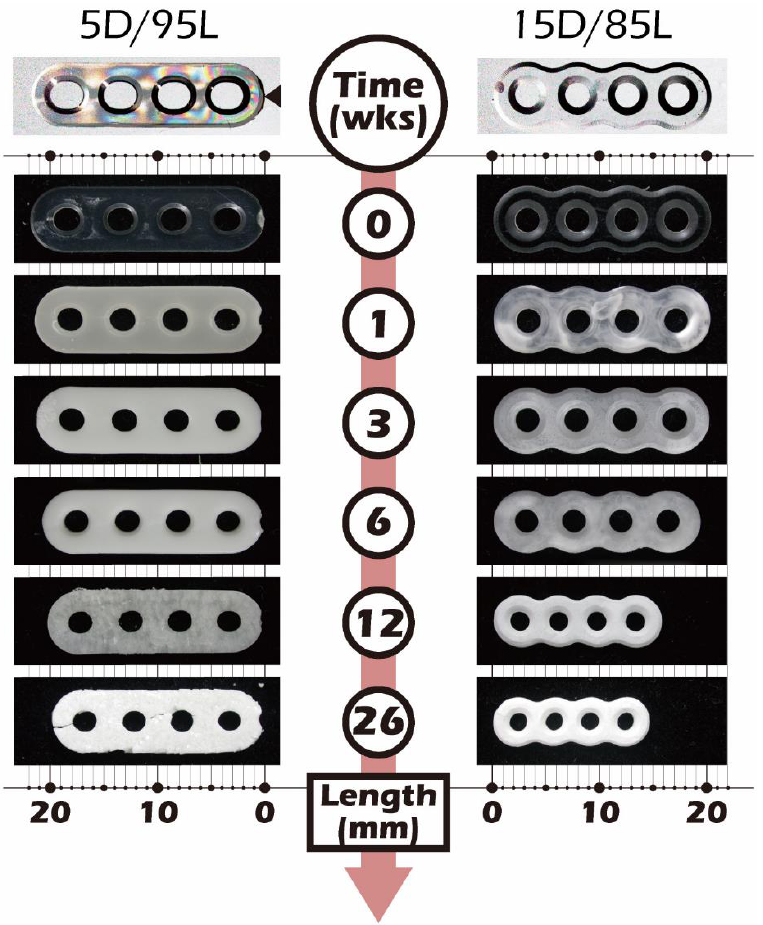
Figure 10. Changes in different PLLA forms with 5% and 15% dextrorotatory ratio after hydrolysis in PBS for 1–26 weeks. The left images are 5D/95L-PLA forms made by molding injection, and the right photos are 15D/85L-PLA forms made by extrusion and milling.